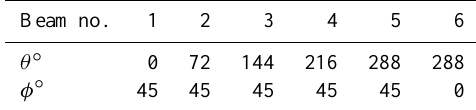
Table 1. Optimum six-beam configuration. Beam